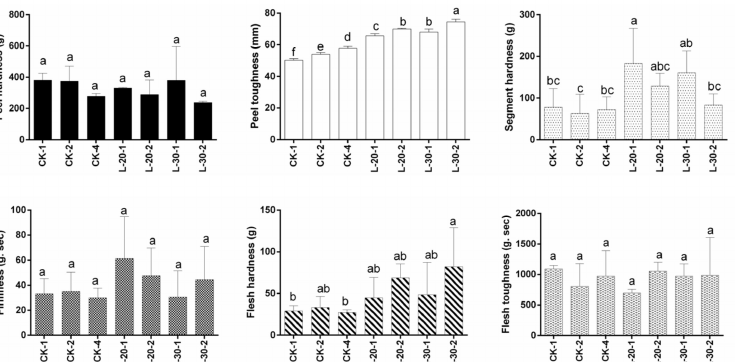
Figure 5. Textural analysis of fully-matured fruits (Sampling time: 15 November 2020) under different fruit load treatments. Within columns, means with the different letter indicate significant differences ( p < 0.05) using Duncan’s test; bars on the columns represent the standard error of the mean ( n = 12).